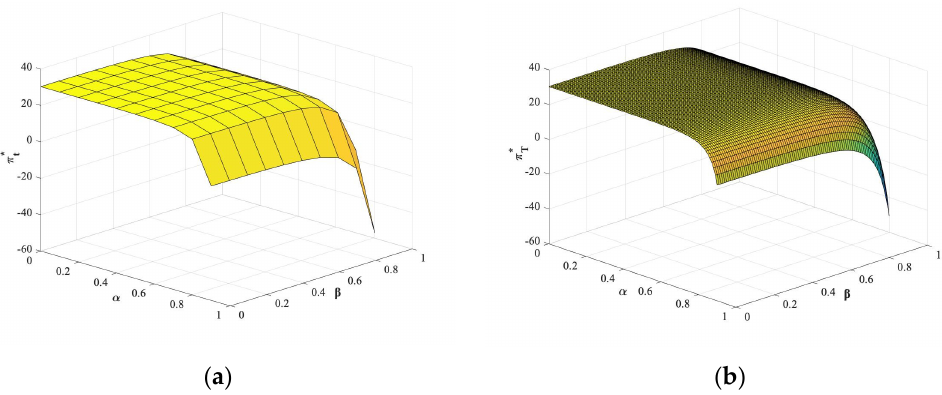
Figure 3. Benefit of the two-way cost-sharing contract on the supply chain. ( a ) Economic benefit and ( b ) joint “economic-environmental” benefit.